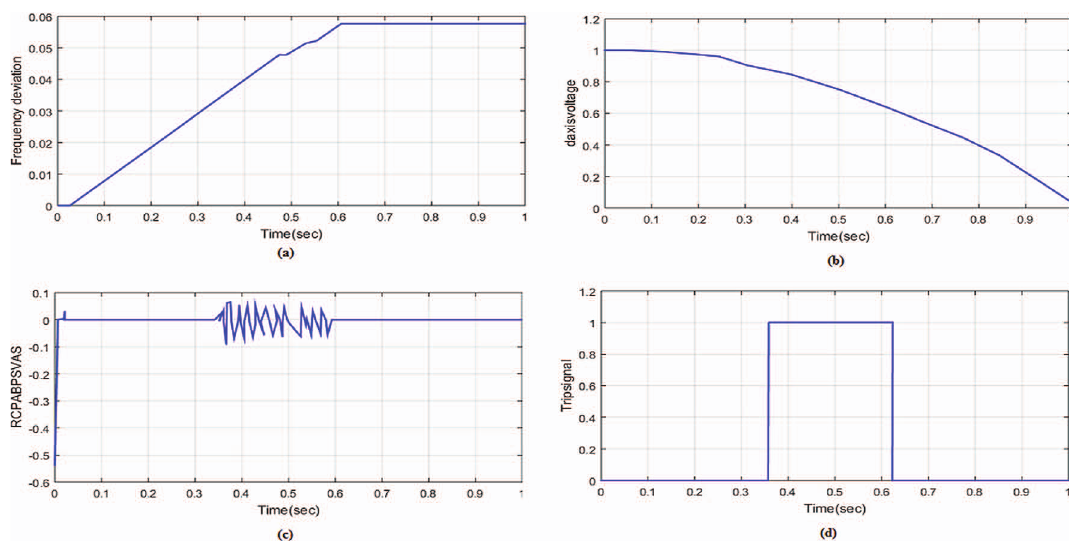
Fig. 13. System performance through Inductive load switching, (a) frequency deviation versus time, (b) d -axis voltage versus time, (c) RCPABPSVAS versus time, and (d) trip signal versus time.